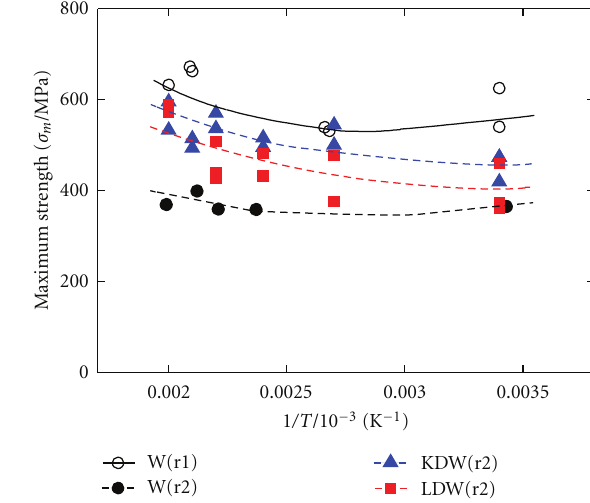
Figure 3: Plots of yield strength against test temperature for various materials.